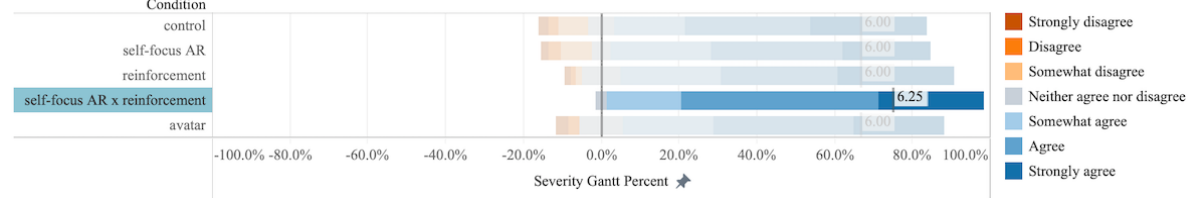
Figure 11. Significantly higher levels of perceived threat severity among participants in the self-focus augmented reality (AR) × reinforcement condition compared to the control condition. No significant differences were found between the control group and the other conditions.